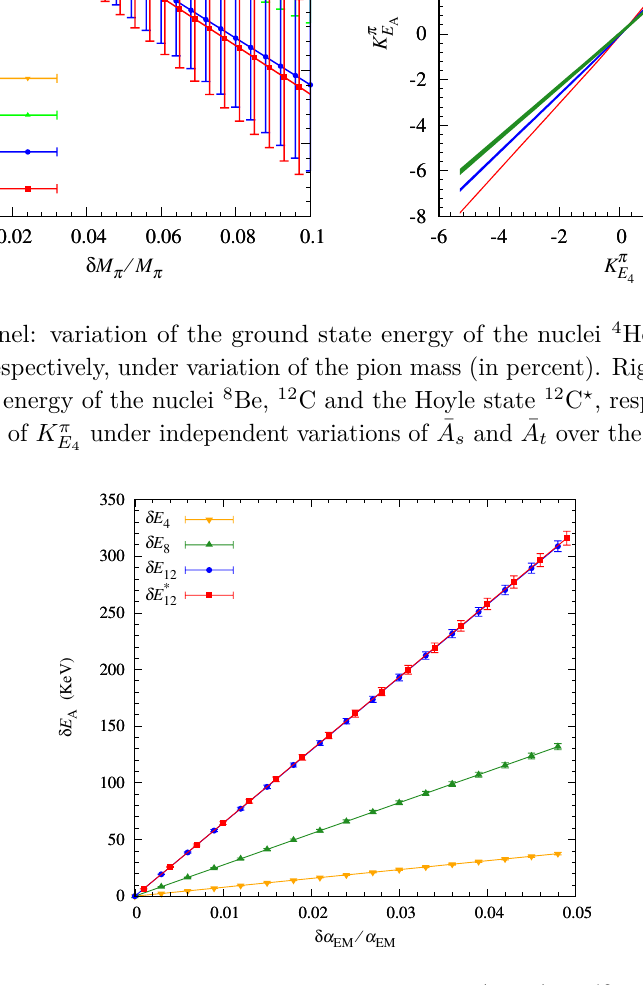
Figure 3 . Variation of the ground state energy of the nuclei 4 He, 4 Be, 12 C and the Hoyle state 12 C ? , respectively, under variation of the fine-structure constant (in